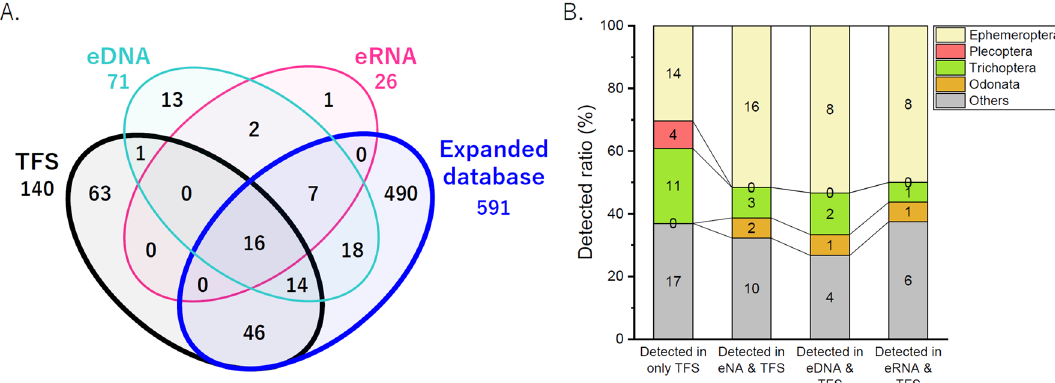
Figure 3. Number of arthropod species detected in the traditional field survey and metabarcoding analysis and their sequence data availability in an expanded database. ( A ) Comparison of the arthropod species detected using eDNA/eRNA metabarcoding and traditional field surveys (TFSs), and the existence of recently registered species in the expanded database. ( B ) Comparison of the ratios between species detected in environmental nucleic acids (eNA [eDNA and eRNA]) and TFS and species detected in only